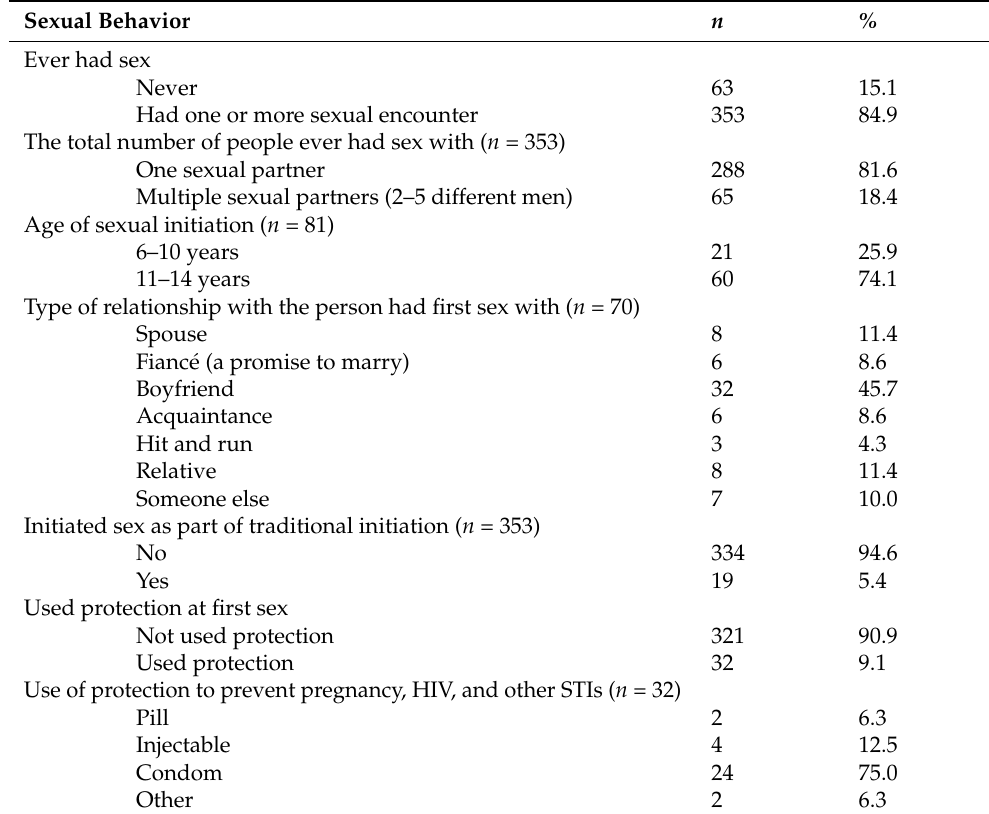
Table 2. Sociodemographic characteristics, violence and sexual behaviors of the young adolescents ( N =